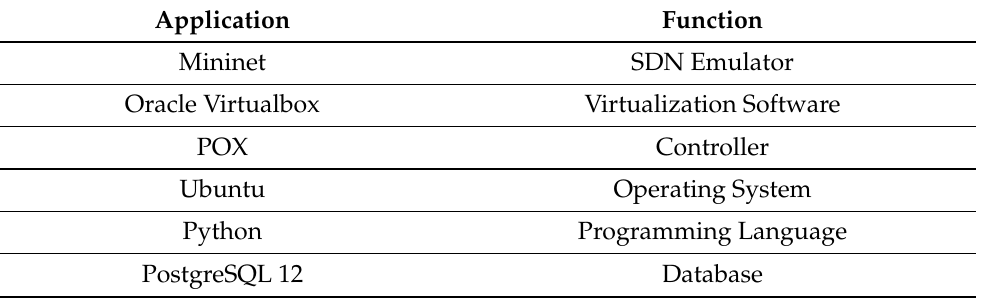
Table 3. Experimental tool set.